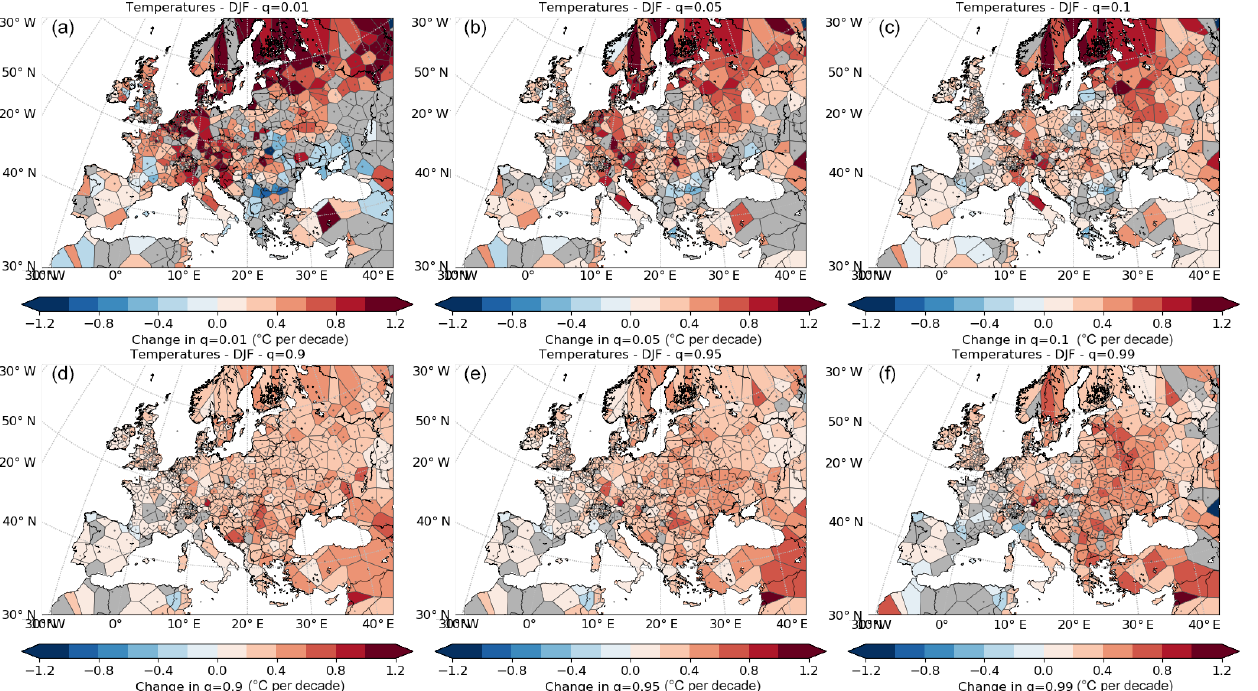
Figure 11. Trend over 1973–2017 in quantiles of temperature ( ◦ C per decade) at (a) 0.01, (b) 0.05, (c) 0.10, (d) 0.90, (e) 0.95 and (f) 0.99 over Europe during winter